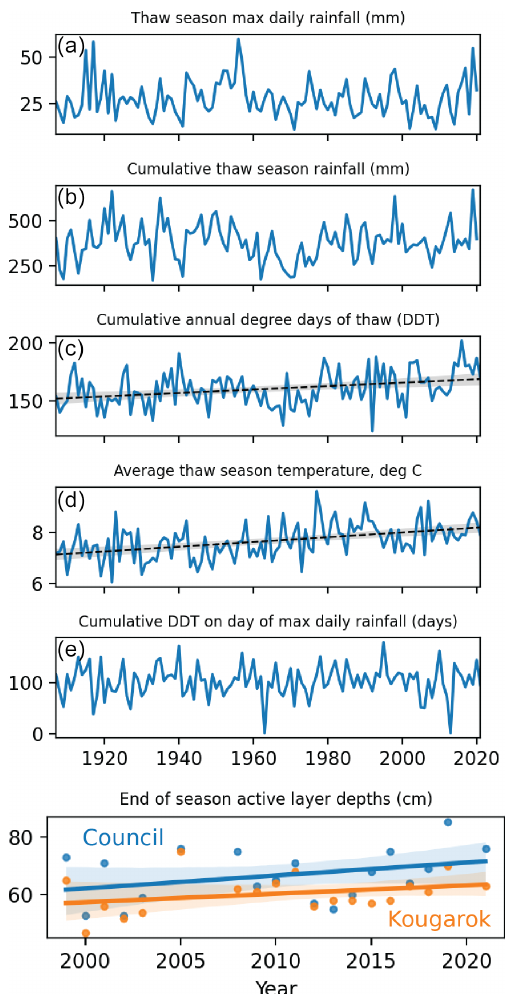
Figure 9. Nome Airport climate data (Alaska Climate Research Center Data Portal, 2022) and active layer thickness datasets. (a) The maximum daily rainfall, in millimeters, for the year’s thaw pe- riod, defined by days in which degree days of thaw (DDT) are in- creasing versus the previous day. (b) The cumulative rainfall (in mm) that fell over the thaw period of that year. Both (a) and (b) appear cyclic over the past century. (c) Cumulative annual DDT for each year, which exhibits a statistically significant linear increase (95% confidence interval). (d) Average temperature of the thaw days of a given year, which exhibits a statistically significant linear increase (95% confidence interval) (e) The cumulative annual DDT on the day of the year of the single largest precipitation event. De- spite potentially increasing cumulative DDT over the century, the timings of thaw initiation and large rainstorms appear to move in tandem, with a consistent ∼ 100d between initial thaw and precip- itation event. (f) Thickness of the active layer at two sites (Council and Kougarok) on the Seward Peninsula since 1999 from data de- rived from the CALM permafrost monitoring network (Brown et al., 2000; Nyland et al., 2021), whose upward trend is not statistically significant (95% confidence